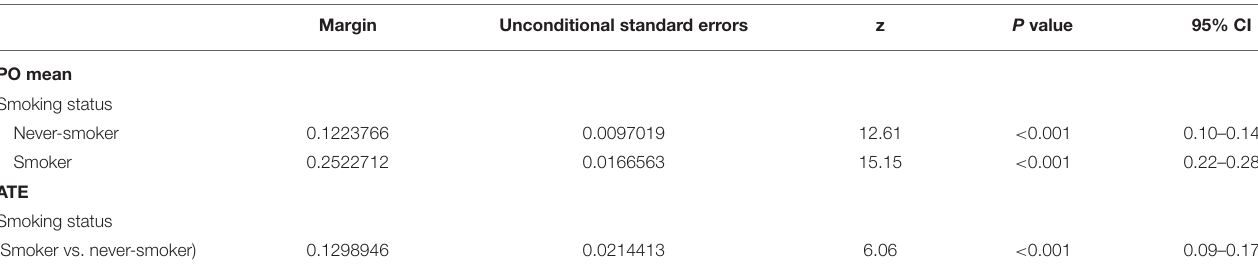
TABLE 3 | Estimates of ATE of householder smoking on being near poverty and PO means of the two smoking status.